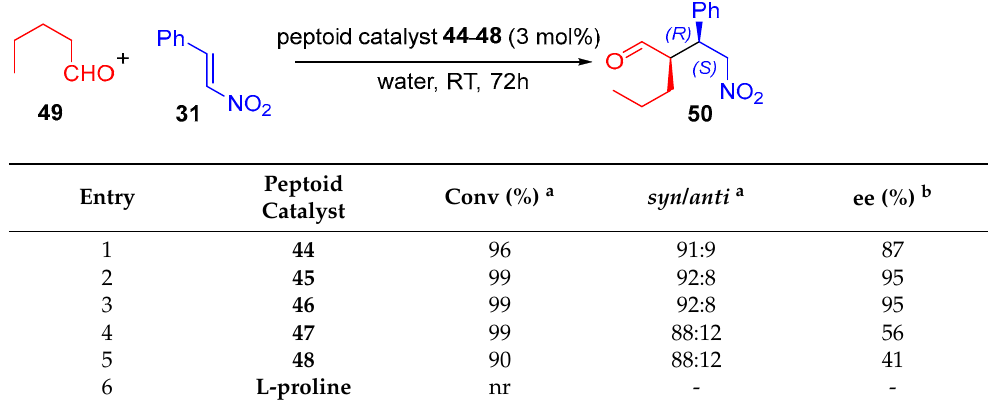
Table 5. Asymmetric Michael addition performed by peptoid catalysts.